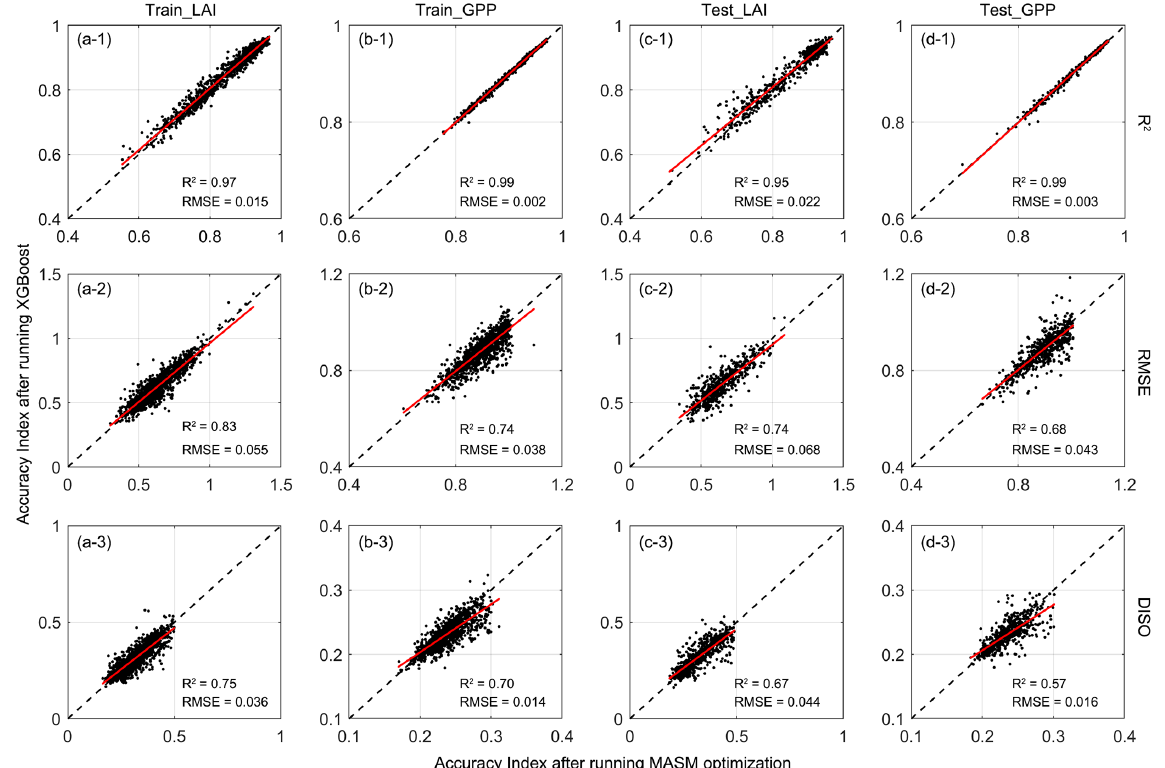
Figure 6. Accuracy indexes ( R 2 , RMSE, and DISO) validation between trained and predicted parameters in simulating LAI and GPP. The x axis represents the accuracy index using MASM posterior parameters; the y axis represents the accuracy index using estimated parameters from the trained XGBoost